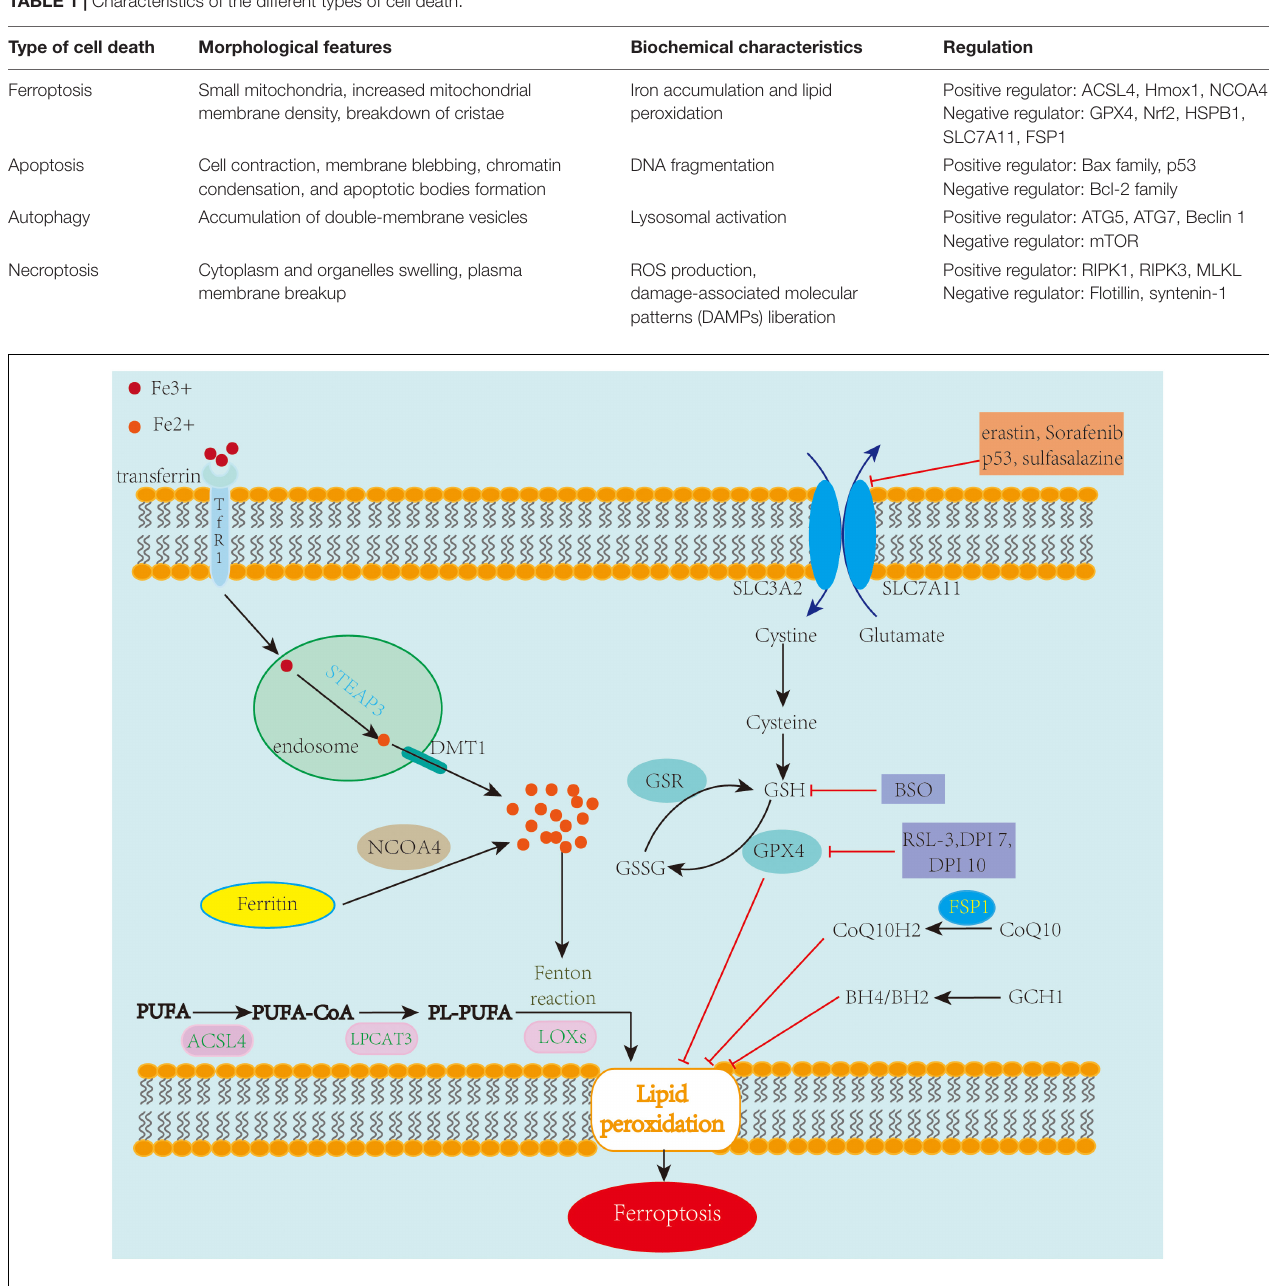
FIGURE 1 | An overview of the mechanisms of ferroptosis. Ferroptosis is an iron-dependent cell death characterized by the accumulation of lipid peroxidation. Free iron ions accumulate and catalyze the Fenton reaction, leading to the formation of lipid peroxides and eventually ferroptosis. The System xc - /GSH/GPX4 axis is regarded as the primary pathway involved in ferroptosis. Inhibiting SLC7A11 and GPX4 leads to the accumulation of lipid peroxidation, causing ferroptotic cell death. Also, FSP1-CoQ10 and GCH1-BH4/BH2 are two GPX4-independent pathways in the inhibition of ferroptosis. are the most susceptible lipids to peroxidation during